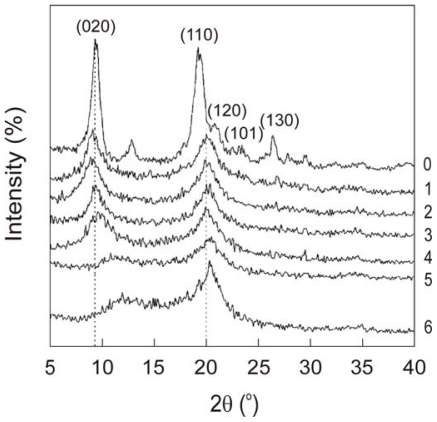
Comparison of X-ray powder diffractograms of chitin and chitosan with different degrees of N-acetylation. Figures 0–6 imply different DA (%): 0-83.1, 1-40.6, 2-36.5, 3-41.3, 4-28.6, 5-13.0, 6-7.2. Reprinted from Carbohydrate Research 340, 2005, Zhang, Y., Xue, C., Xue, Y., Gao, R., Zhang, X., Determination of the degree of deacetylation of chitin and chitosan by X-ray powder diffraction, 1914–1917, Copyright (2010), with permission from Elsevier [74].